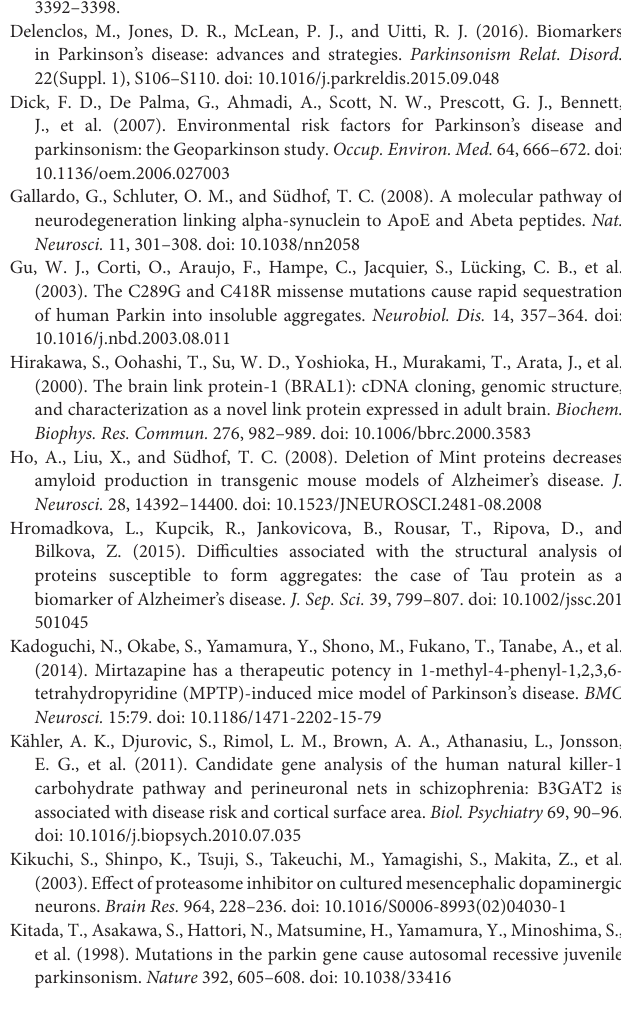
Figure S1 | Verification of the specificity of Hapln2 antibody. (A) Representative photomicrographs showing the expression pattern of Hapln2-GFP in HEK293T cells transfected with Hapln2-GFP plasmids. (B) Western blot analysis of cell lysates of 293T cells transfected with Hapln2-GFP plasmids using anti-GFP and anti-Hapln2 antibodies. (C) Western blot analysis of tissue lysates of the substantia nigra of adult rat using anti-Hapln2 antibody. Figure S2 | Verification of the specificity of Hapln2 in situ hybridization probe. Panels (A–G) show the hybridization signals of Hapln2 in ventral midbrain (A) , cerebral cortex (B) , striatum (C) , cerebellum (D) , hippocampus (E) , olfactory bulb (F) , and brain stem (G) of rat slices using a sense probe. Scale bar = 300 µ